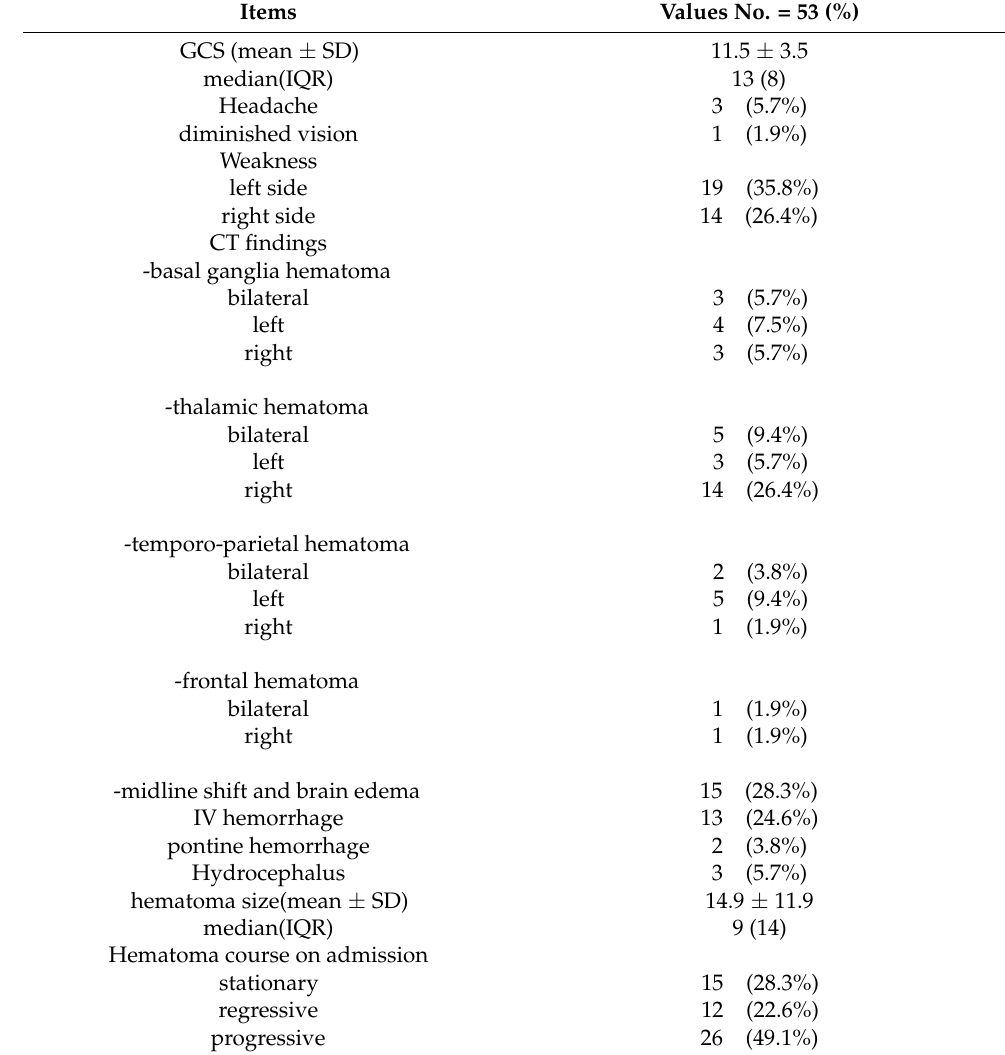
Table 2. Neurological symptoms and CT brain findings on